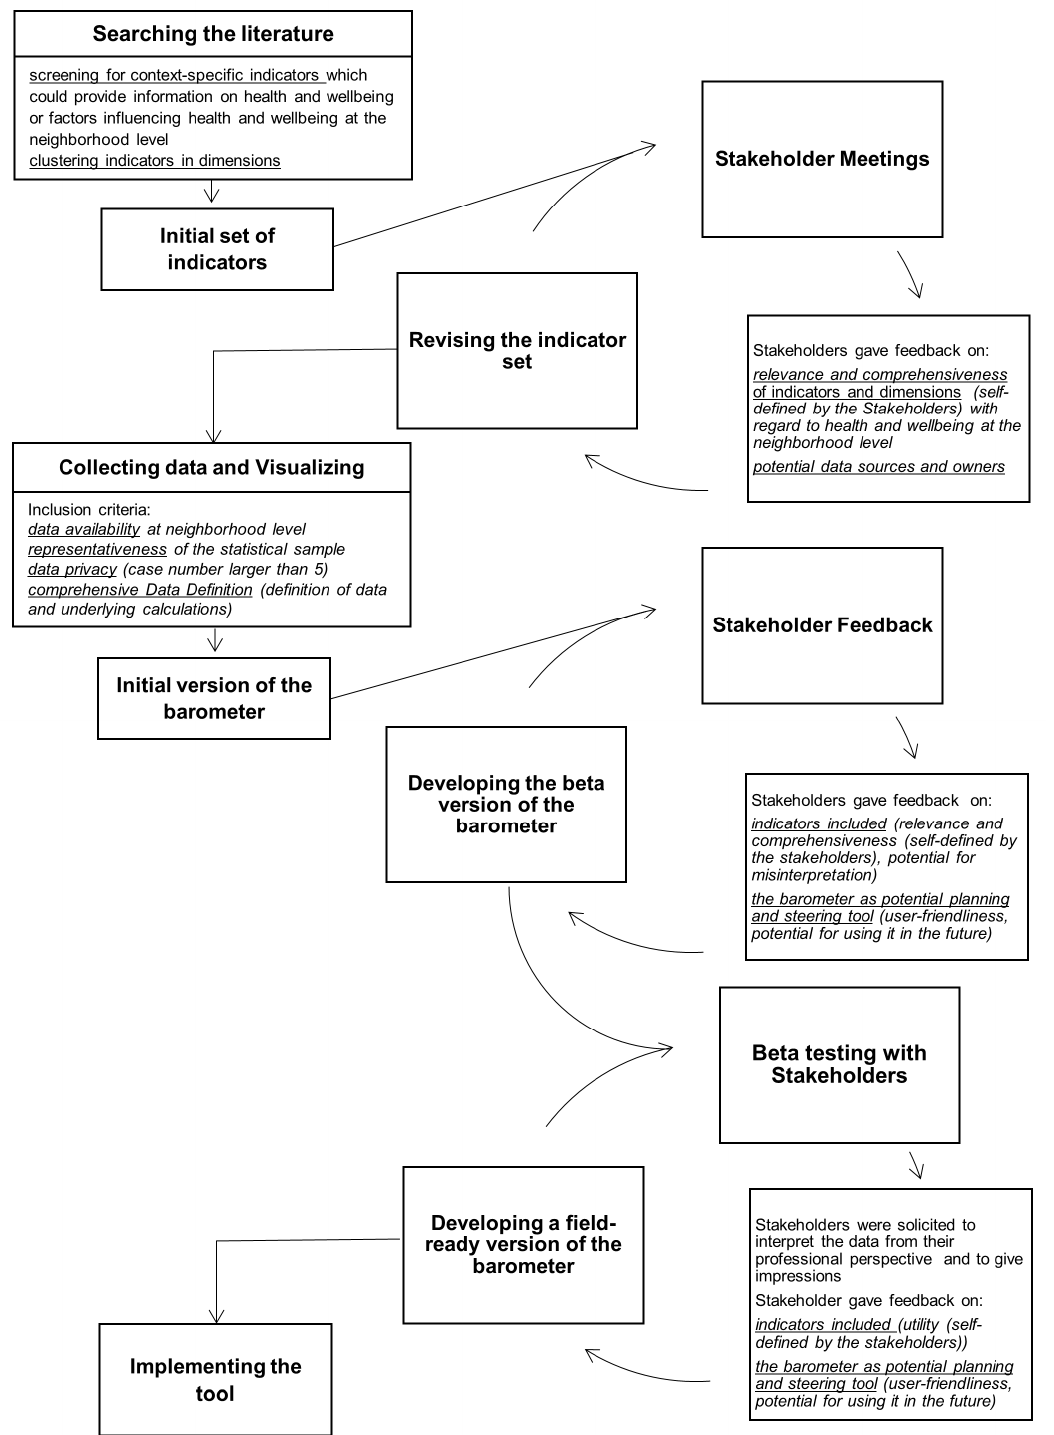
Figure 1. Steps in developing the neighborhood barometer